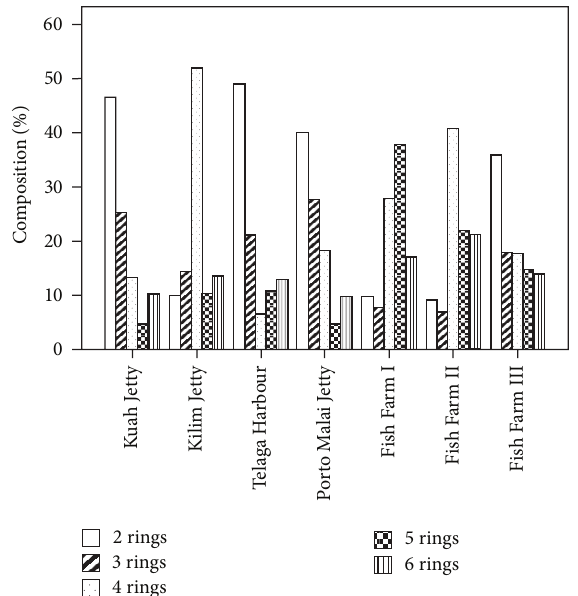
Figure 2: Composition pattern (%) of PAHs by the number of rings: 2-,3-,4-,5-, and 6-ring PAH.